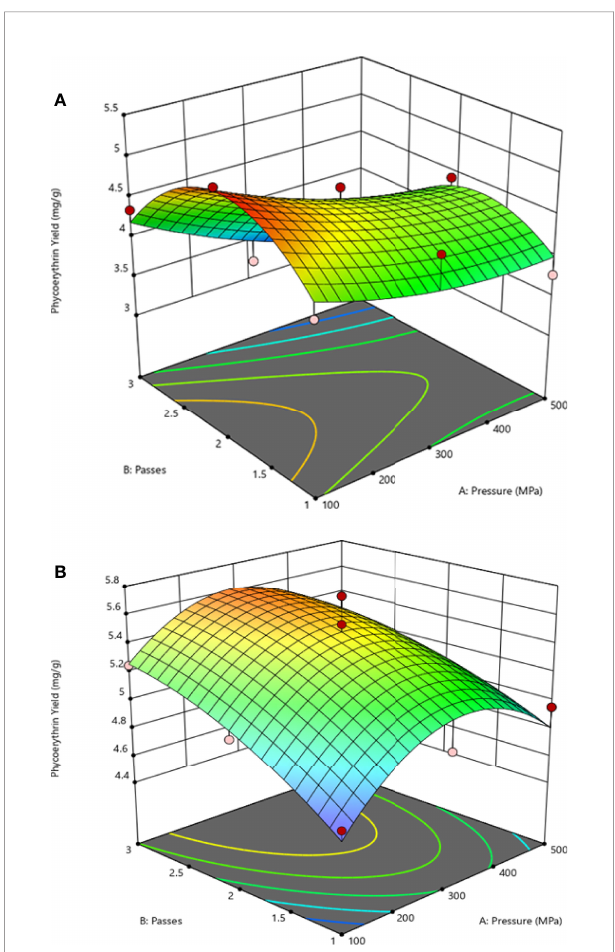
FIGURE 3 | Response surface (3D) plots to display the effect between the pressure (X 1 ) and passes (X 2 ) by solvent extraction on the extraction yield: (A) effect between X 1 and X 2 under buffer phosphate, (B) effect between X 1 and X 2 under distilled